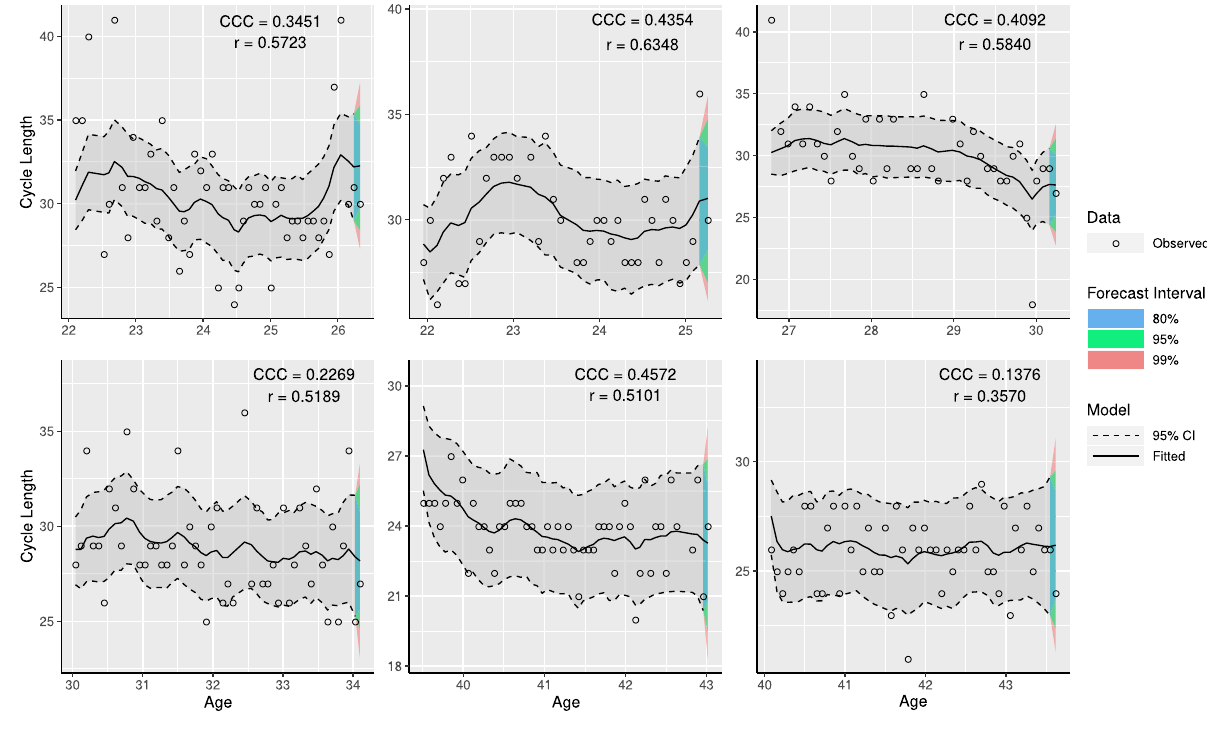
Figure 6. Age versus fitted menstrual cycle length for six women with more than 40 repeated measurements with addition of 95% credible interval (dashed line), 80%, 95%, and 99% forecast intervals for their next cycle, and observed menstrual cycle length (points) using the model y ij = m ij + γ ij + c ij , when dropping the term r ij from the model. The estimated concordance correlation coefficient (CCC), and Pearson correlation coefficient (r) between fitted and observed values are reported for each woman. Accuracy ( C b ) can be obtained using C b = CCC / r